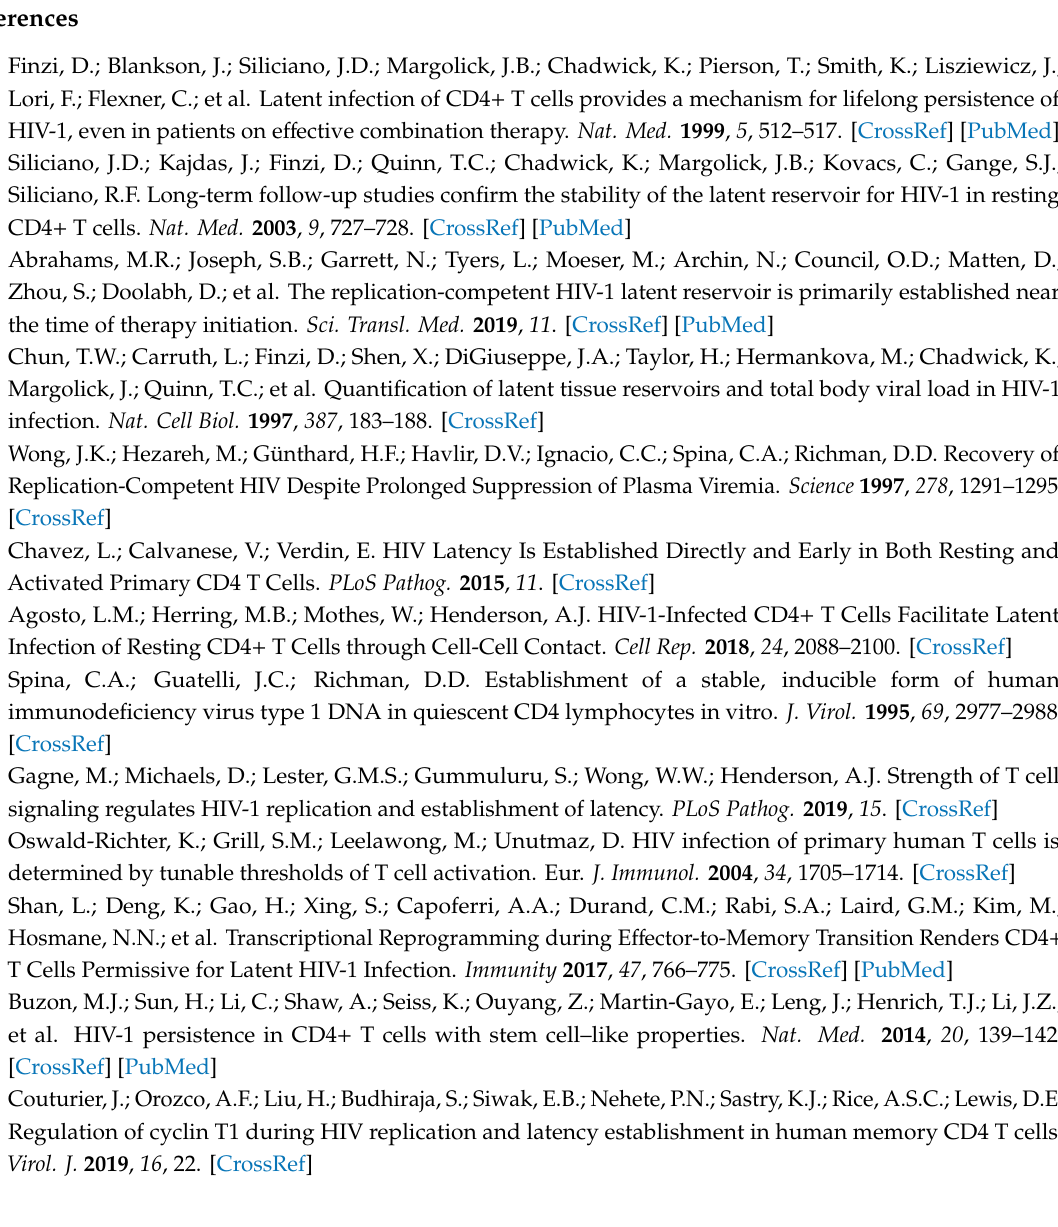
Figure S1: Repression of HIV-1 transcription over time by dCas9-KRAB. Figure S2: dCas9-KRAB mediates post-translational modification of histones at the HIV-1